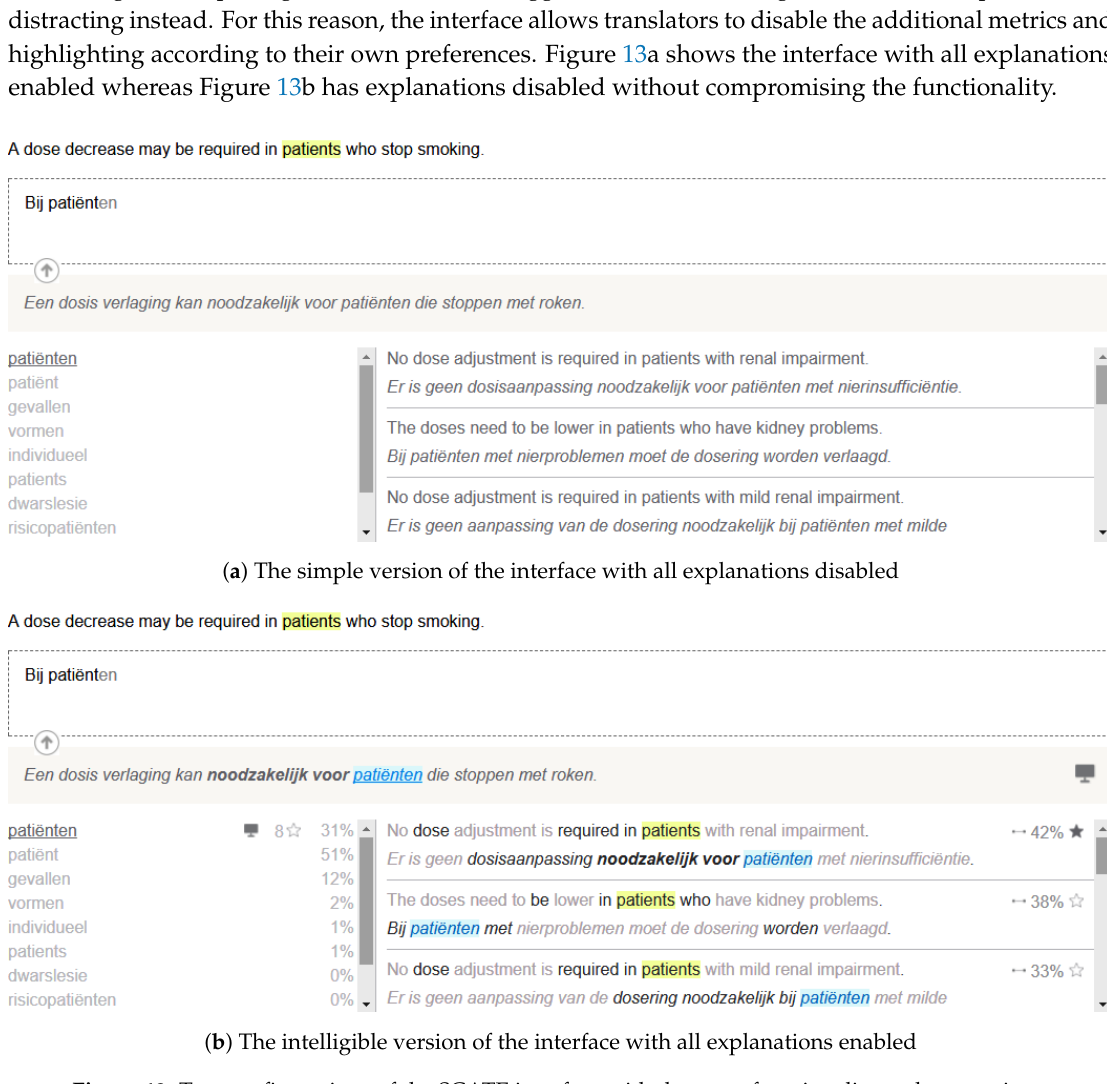
Figure 13. Two configurations of the SCATE interface with the same functionality and